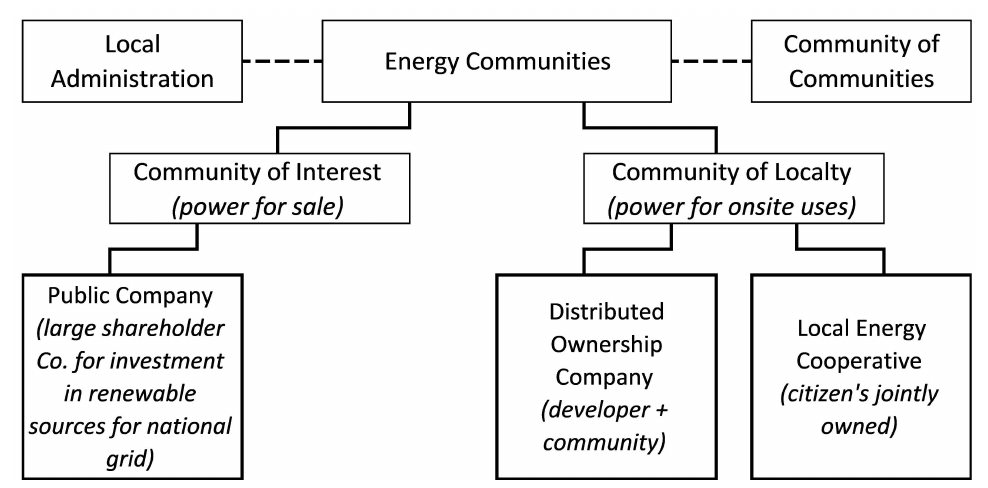
Figure 2. Typology of Energy